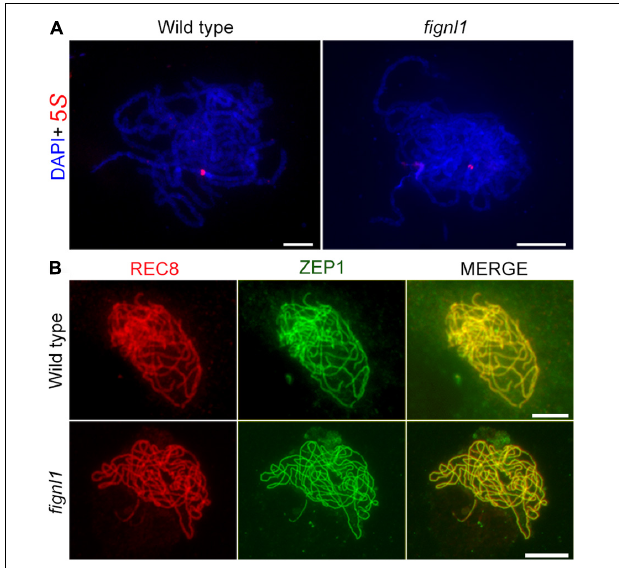
FIGURE 3 | The mutation of FIGNL1 has no effect on homologous chromosome pairing and synapsis. (A) FISH analysis with 5 S rDNA probes (red) of the wild type and fignl1 mutant. Chromosomes were stained with DAPI (blue). (B) Dual-immunolocalization of REC8 (red) and ZEP1 (green) in the wild type and fignl1 mutant. Scale bars, 5 µ